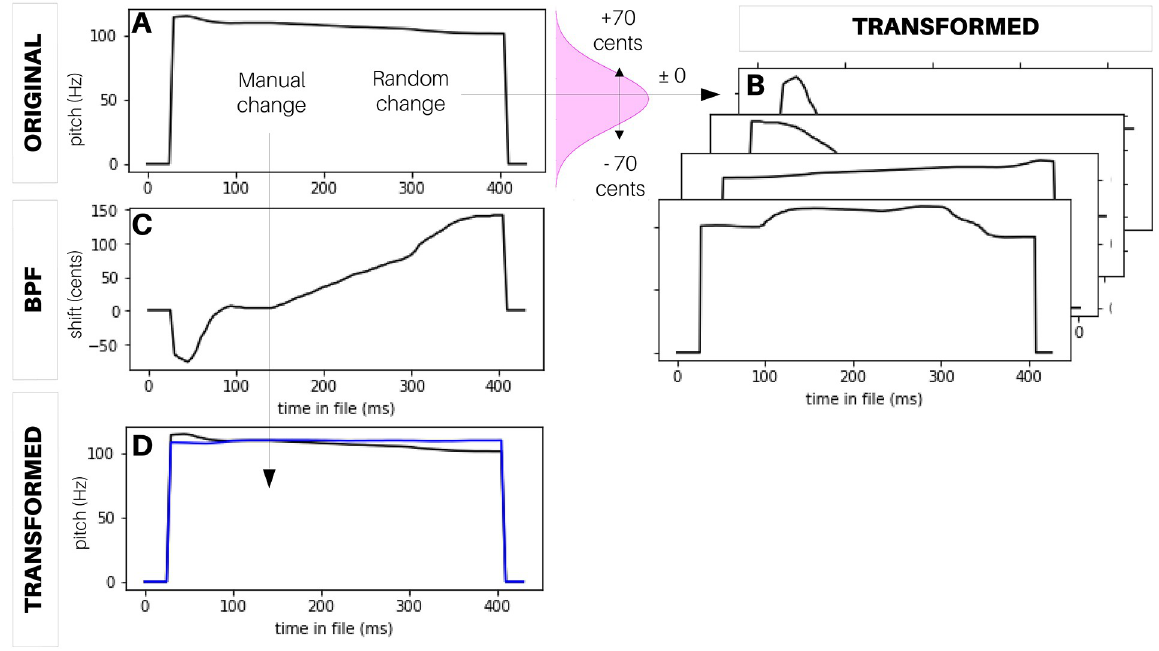
Fig 3. Examples of pitch manipulations created with CLEESE. A: pitch of an original male speech recording (a 400ms utterance of the word ‘hello’). B: Random pitch transformations of the original, where pitch shift values at each breakpoint are drawn from a Gaussian distribution. C: Manually-specified BPF created to flatten the pitch contour of the original recording. D: Resulting flat-pitch transformation, compared to original.